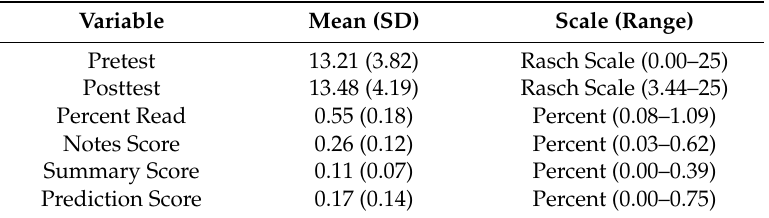
Table 2. Descriptive statistics for the variables used in the regression